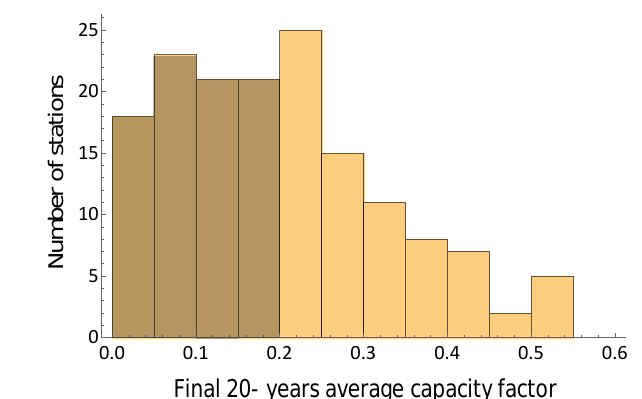
Figure 2. Histogram for the final 20-years average capacity factor ˆ M for the 156 stations. The 83 eliminated stations with capacity factor less than 20% are shaded.